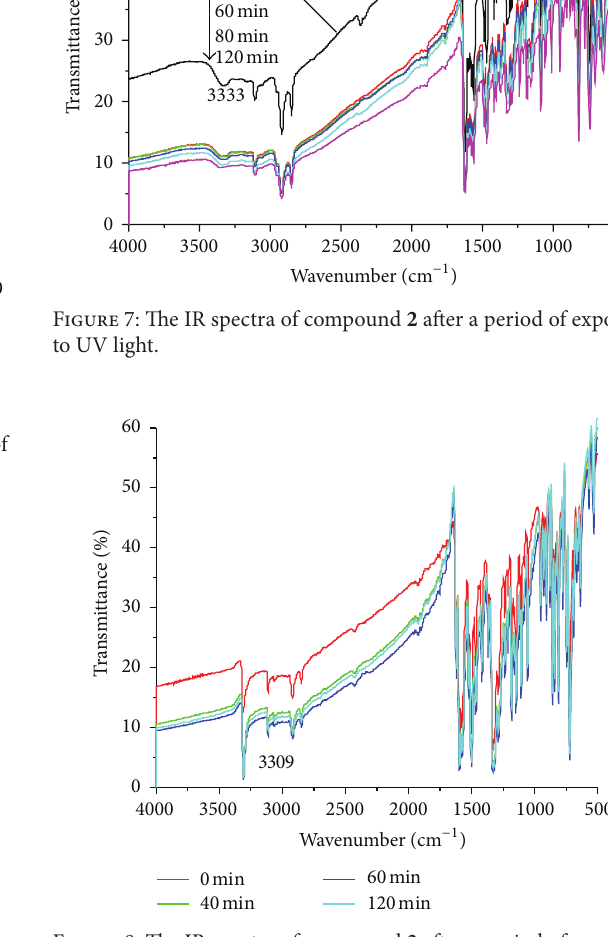
Figure 8: The IR spectra of compound 3 after a period of exposure to UV